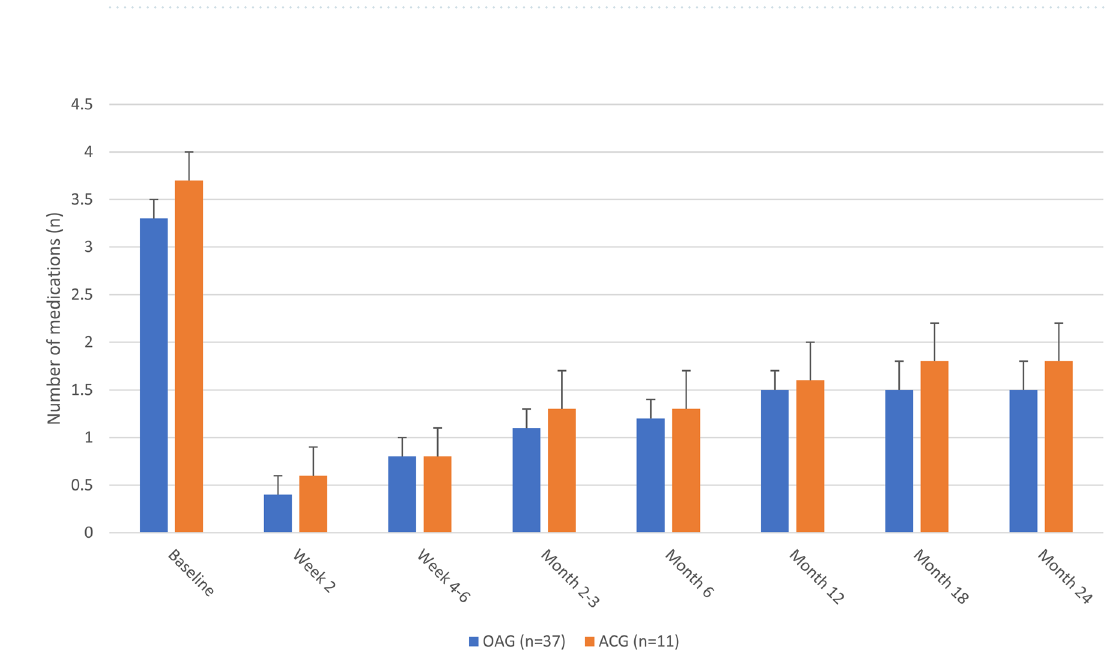
Table 4. Pre-specified IOP and medication outcomes at each time point for the open-angle glaucoma and angle-closure glaucoma groups. ACG angle-closure glaucoma, IOP intraocular pressure, mmHg millimeters of mercury, OAG open-angle glaucoma (includes primary and pseudoexfoliation open-angle glaucoma).